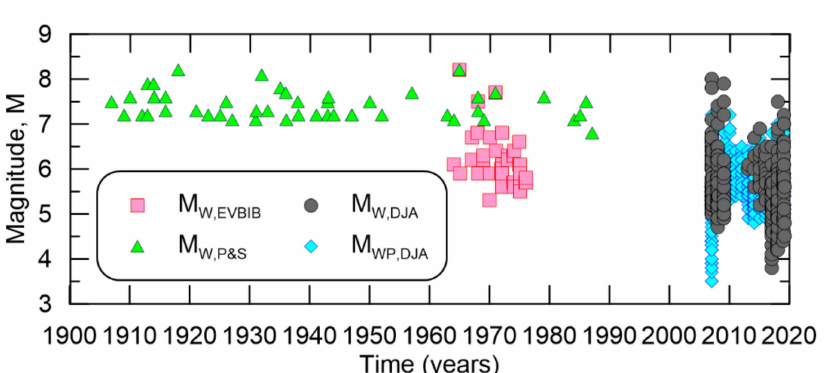
Figure 3. Moment magnitude types from DJA and bibliographic sources, and timeframes when they are valid in the Indonesian